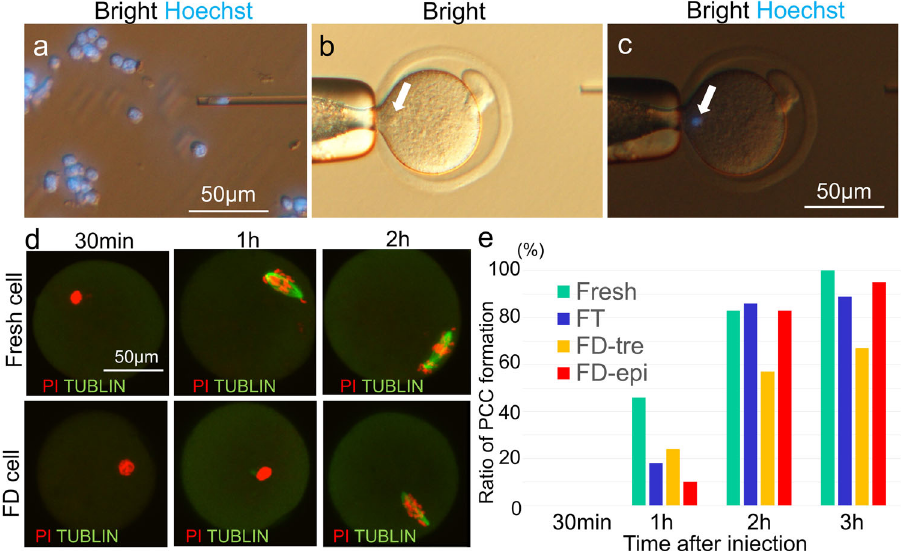
Fig. 3 Nuclear injection and premature chromosome condensation (PCC). a – c FD somatic cell nucleus was injected into enucleated oocytes; the arrow indicates injected nucleus. Somatic cell nuclei were stained by Hoechst33342. d Timing of PCC formation of fresh or FD somatic cells after nuclear injection into oocytes. e Percentage of PCC formation in oocytes from 30 min to 3 h after nuclear injection. n = 18 – 40 oocytes examined over 3 independent experiments. See Supplementary Table 2 for more